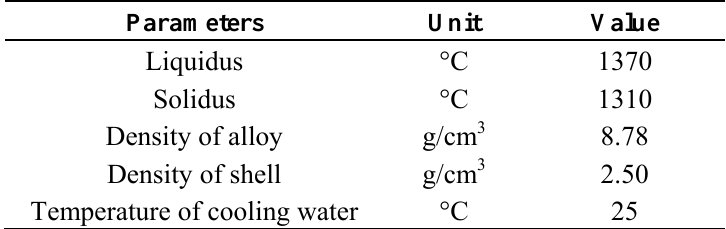
Table 1. The parameters used in the calculation (Superalloy DD6 [44,45] )